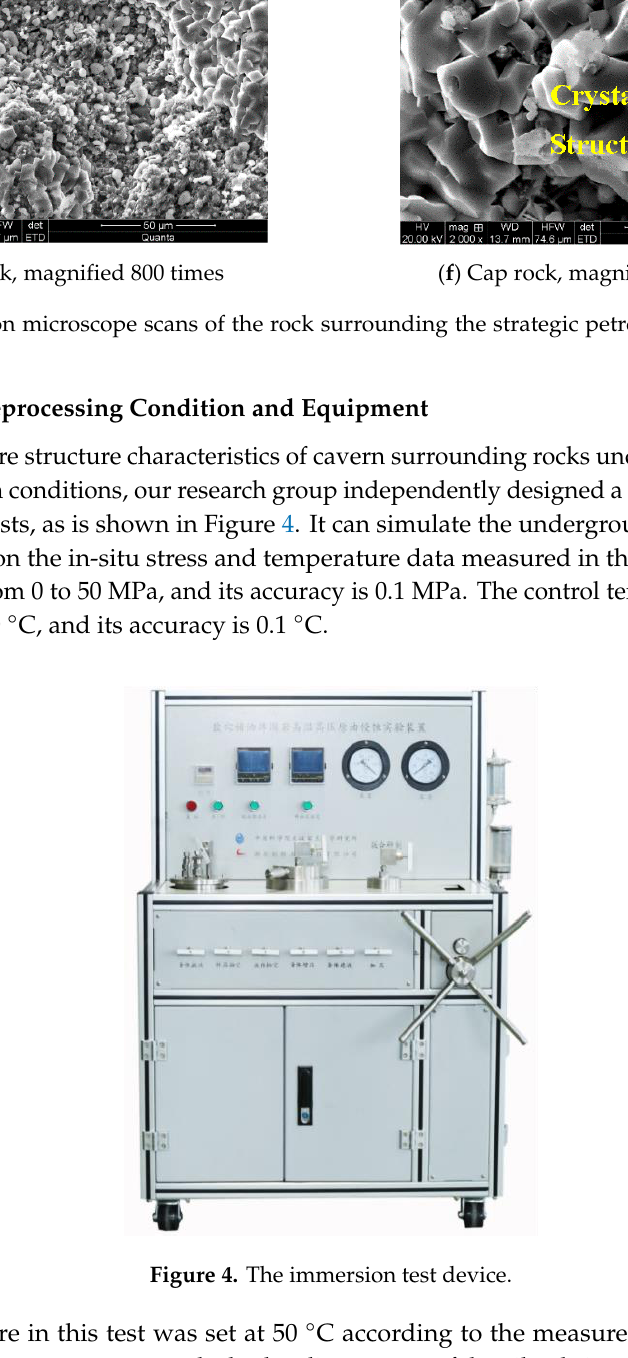
Figure 5. The hydraulic pressure schematic graph of the SPR salt cavern.